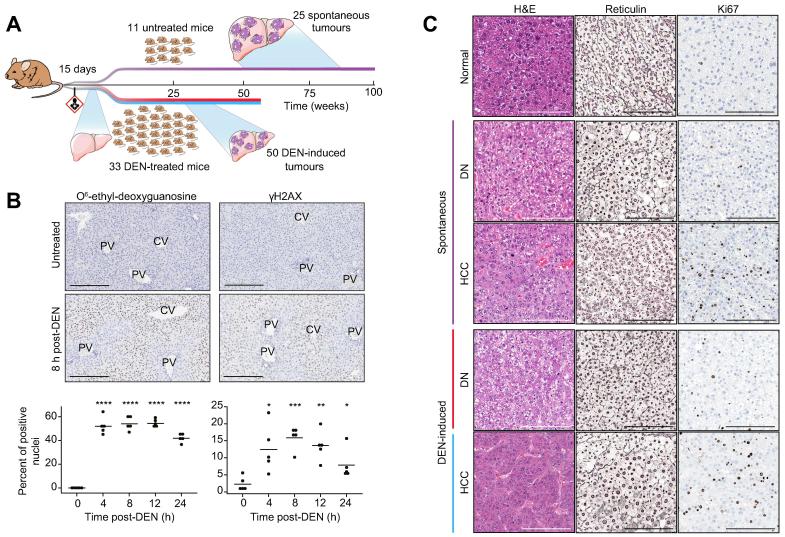
DEN-initiated carcinogenesis in mouse hepatocytes. (A) Overview of experimental design. Cohorts of C3H male mice aged 14–16 days were either administered DEN or left untreated. Liver samples were collected during the first 24 h after DEN exposure for histopathological analysis, or mice were aged to develop tumours. Dysplastic nodules and HCCs were collected from cohorts of mice 24–26 weeks and 26–40 weeks, respectively, after administration of DEN; spontaneous tumours were collected from mice aged 37–76 weeks. (B) In situ detection and quantification of DEN-induced DNA damage. Representative photomicrographs of immunohistochemistry for O6-ethyl-2-deoxyguanosine and gamma-H2AX in untreated mice and 8 h post-DEN injection. All scale bars = 200 μm. Original magnification ×200. Automated image quantification was used to evaluate the dynamics of DNA damage for O6-ethyl-2-deoxyguanosine and gamma-H2AX over the course of 24 h (n = 5 samples per timepoint; bar indicates mean; Welch two-sample t test: *p <0.05, **p <0.01, ***p <0.001, ****p <0.0001). (C) Histology of murine hepatocellular neoplasms. Representative photomicrographs of serial sections of normal liver tissue and liver tumours arising in DEN-treated and untreated mice. H&E staining demonstrates tissue morphology; reticulin staining is used to assess architecture (normal: staining around each cord of hepatocytes; DN: loss of regular architecture; HCC: thickened trabeculae and corresponding reduction in staining); and Ki67 identifies mitotic cells (normal adult liver is mostly quiescent; DN and HCC show increasing numbers of dividing cells). All scale bars = 200 μm. Original magnification ×200. CV, central vein; DEN, diethylnitrosamine; DN, dysplastic nodule; H&E, haematoxylin and eosin; HCC, hepatocellular carcinoma; PV, portal vein.